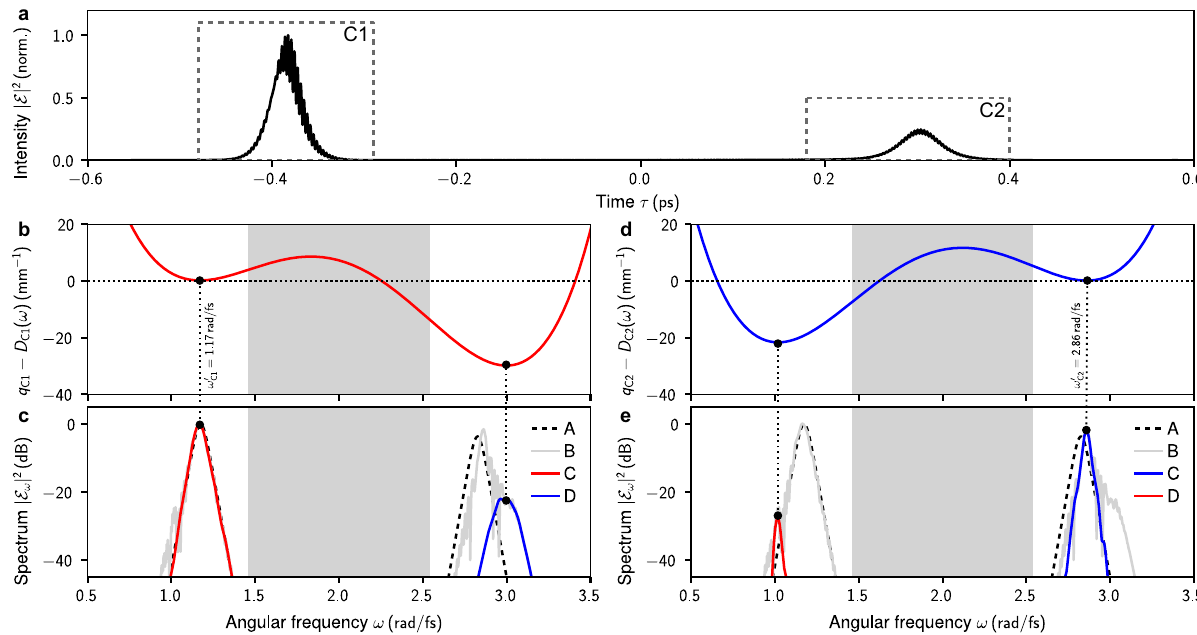
25mm . ( a ) Normalized time- = β(ω) β(ω ′ C1 ) β 1 (ω ′ C1 )(ω ω ′ C1 ) , = − − − 2 / max 2 E E ω ( z ) | ω ( z = 0mm ) | | [| ] 25mm (labeled B), and spectra of =